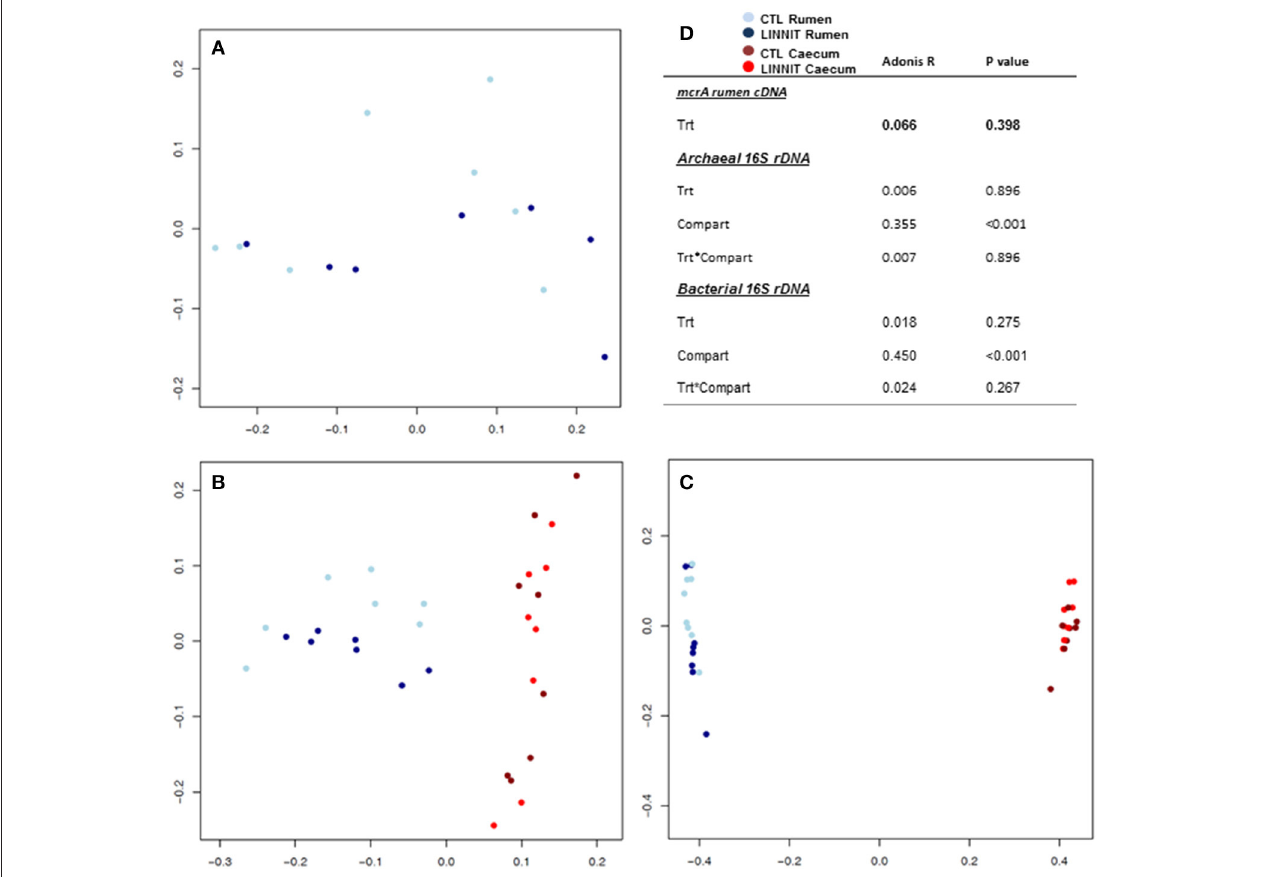
FIGURE 1 | (A) Principal coordinate analysis (PCoA) plot of ruminal mcrA cDNA reads distribution in CTL and LINNIT animals; (B) archaeal; and (C) bacterial 16S rRNA gene sequences of microbial communities inhabiting the rumen and cecum of CTL and LINNIT growing bulls. PCoA biplots are based on Bray-Curtis distances mcrA and 16S rRNA gene amplicon sequencing data. Statistical comparisons based on the underlying distance matrices are shown in (D)